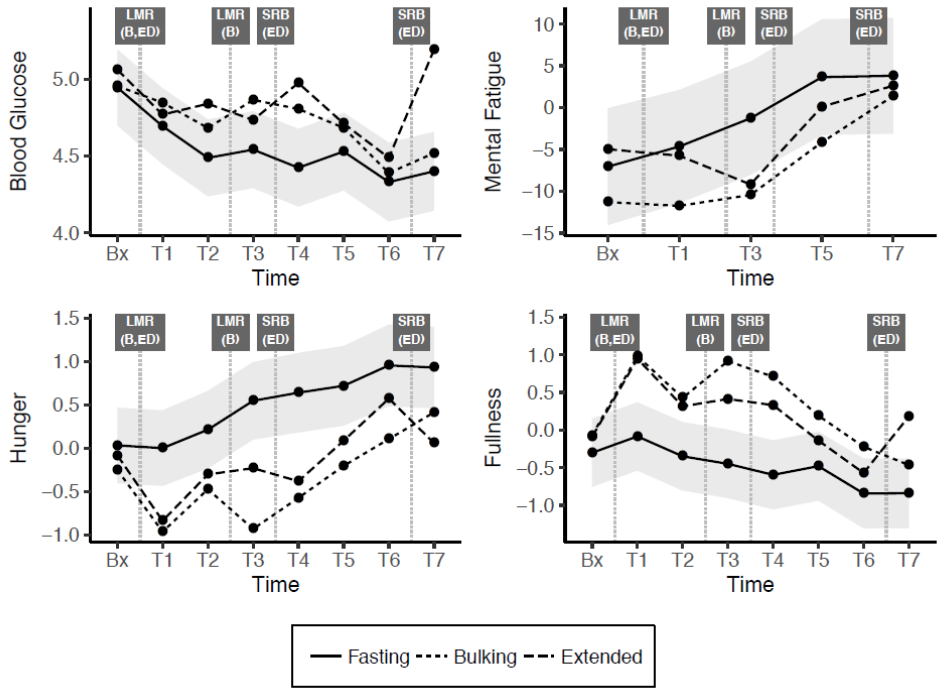
Figure 2. Change across the day in blood glucose, mental fatigue, hunger and fullness (shaded grey bands indicate 95% confidence interval (CI) for difference from fasting condition). Bx = baseline, T= Time(x), LMR = Liquid Meal Replacement, SRB = Snack Replacement Bar, B = Bulking, ED = Extended Distribution.